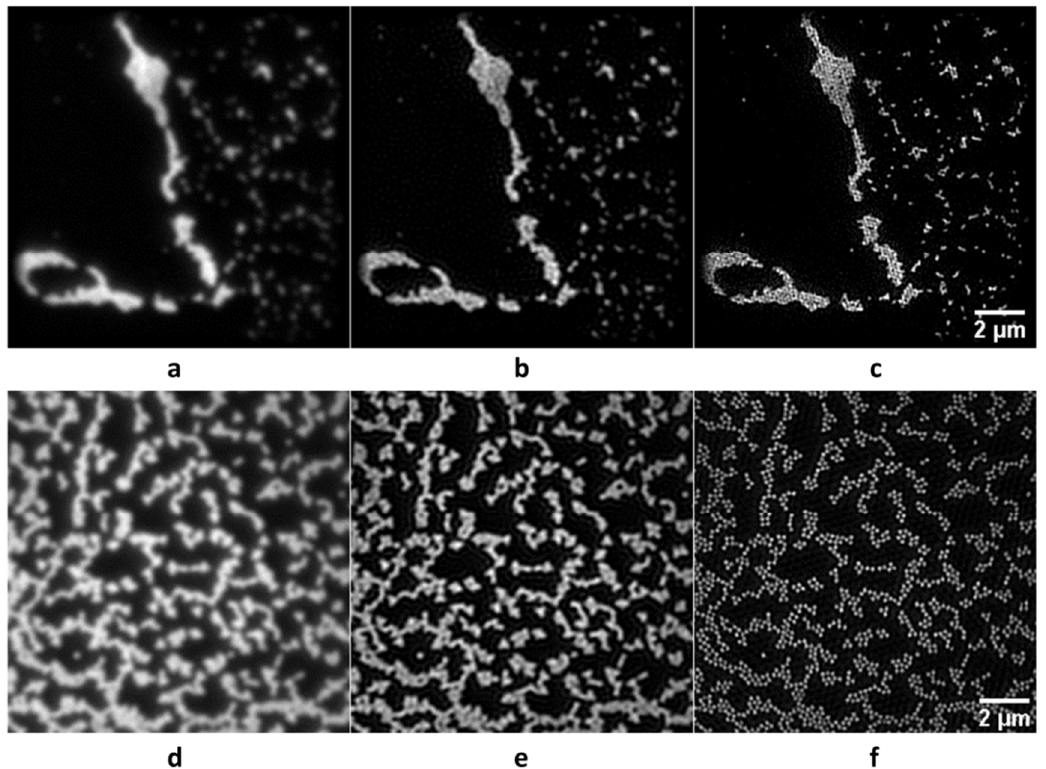
Figure 3. Images of fluorescent nano-beads with a size of 100 nm (upper part) as well as 200 nm (lower part) using wide-field microscopy ( a , d ), wide-field microscopy with a Wiener filter ( b , e ) or SIM ( c , f ); excitation wavelength: λ 0 = 488 nm; detection range: λ D ≥ 515 nm; Plan-Neofluar 40 × /1.30 oil immersion objective lens.